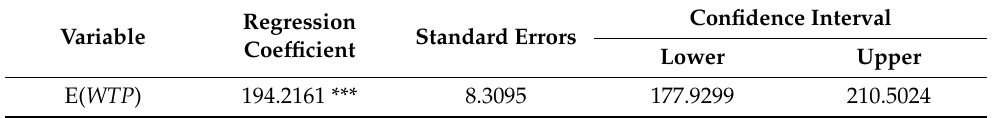
Table 4. Estimation results of E( WTP